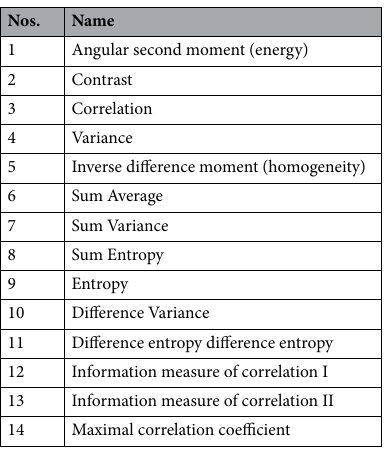
Table 4. Haralick texture